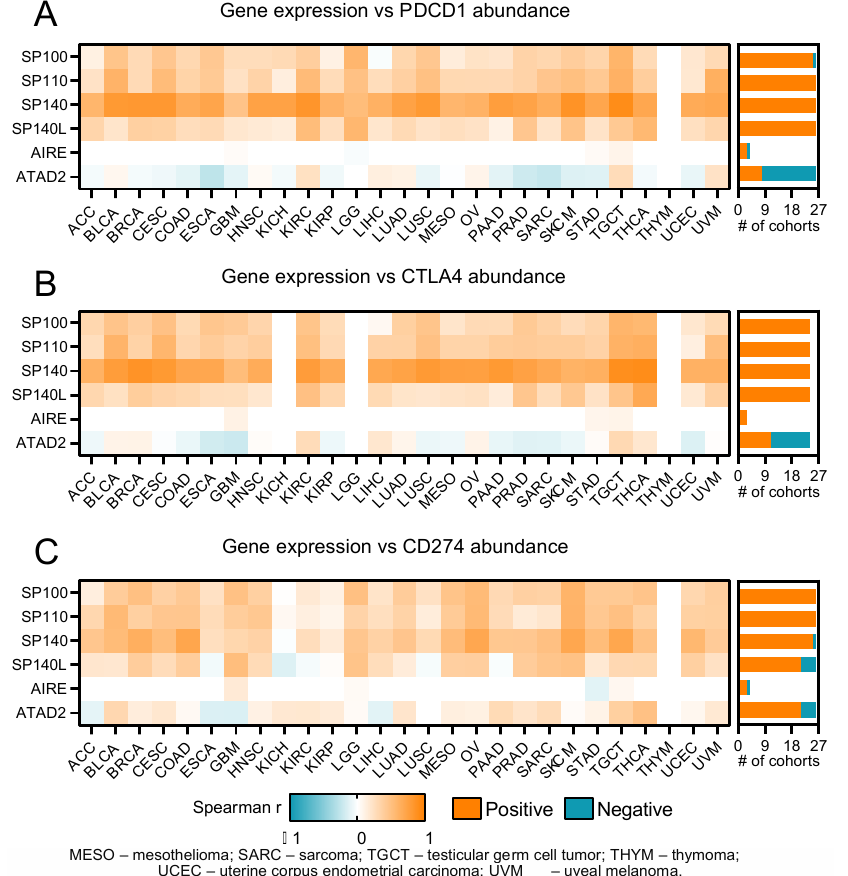
Figure 5. The heatmap of Spearman’s correlation between SP family ( SP100 , SP110 , SP140 , and SP140L ) and control genes’ ( AIRE and ATAD2 ) expression and immunoinhibitors’ (( A ) PDCD1, ( B ) CTLA4, and ( C ) CD274) abundance among 27 tumor types with the number (# of cohorts) of posi- tively (orange) or negatively (aquamarine) correlated cohorts. Color of the heatmap denotes either increase (orange) or decrease (aquamarine) rho value with statistical significance ( p < 0.05).